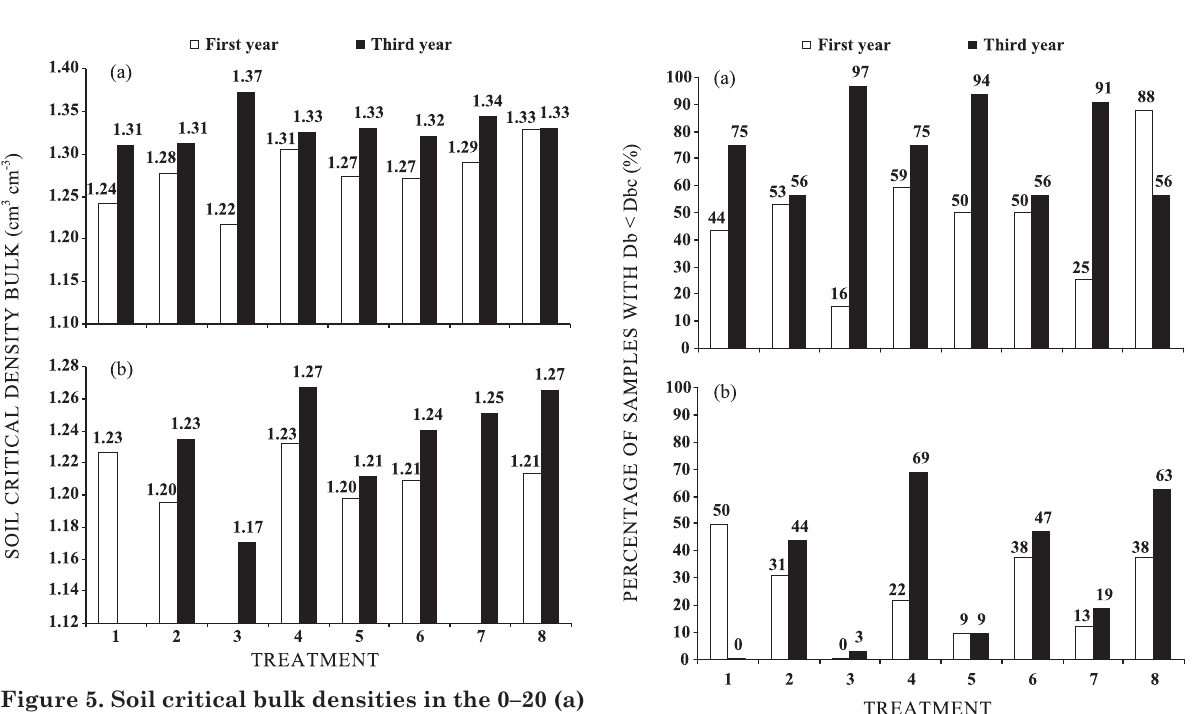
Figure 6. Percentage of samples with lower soil bulk density (Db) than the critical soil bulk density (Db ), in the first and third year of the c experiment in the 0–20 (a) and 20–40 cm (b) layers. Treatments: sunflower+millet (1); sunflower+forage sorghum (2); sunflower+sunn hemp (3); sunflower+ chiseling (4); triticale+ millet (5); triticale+forage sorghum (6); triticale+ sunn hemp (7) and triticale+ chiseling